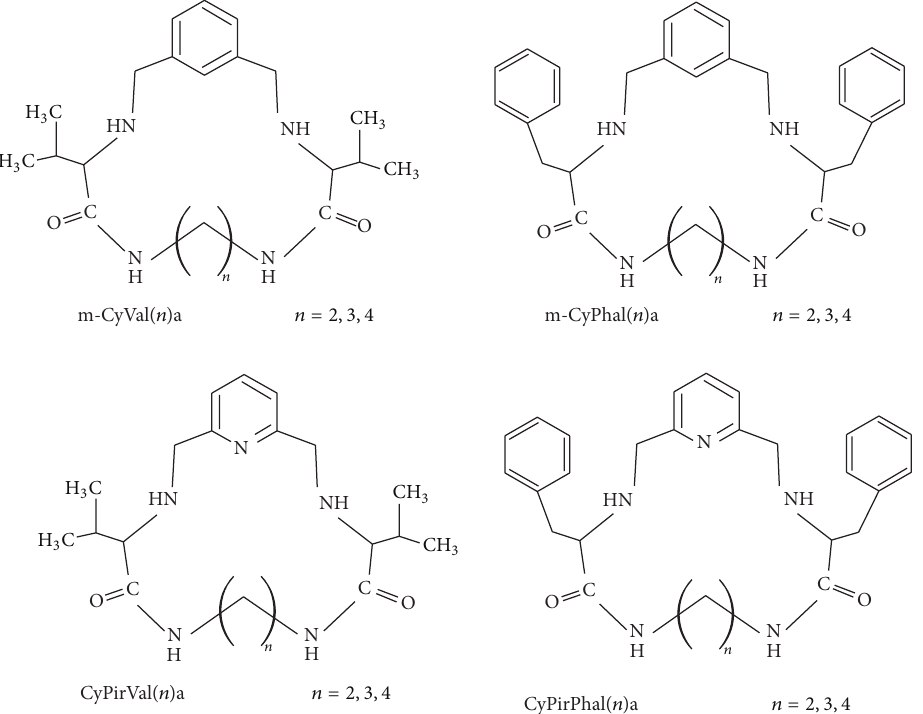
Figure 2: Structures of investigated cyclic